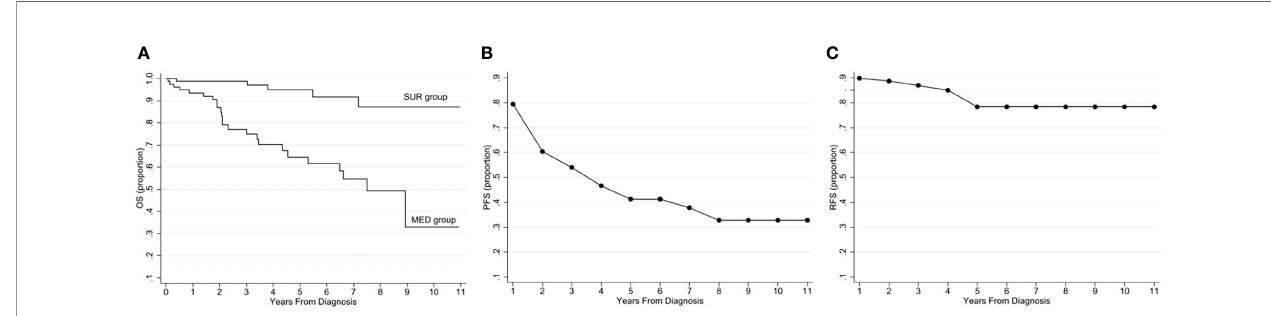
FIGURE 2 | Survival graphs on 174 patients with a primary PNET diagnosis. (A) Overall survival in the MED and SUR groups, (B) progression-free survival in the MED group, (C) recurrence-free survival in the SUR group. MED, group of patients treated medically or with watchful wait; OS, overall survival; PFS, progression-free survival; PNET, pancreatic neuroendocrine tumor; RFS, recurrence-free survival; SUR, group of surgically